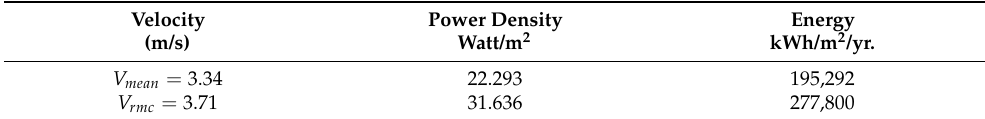
Table 8. Power density and energy for different